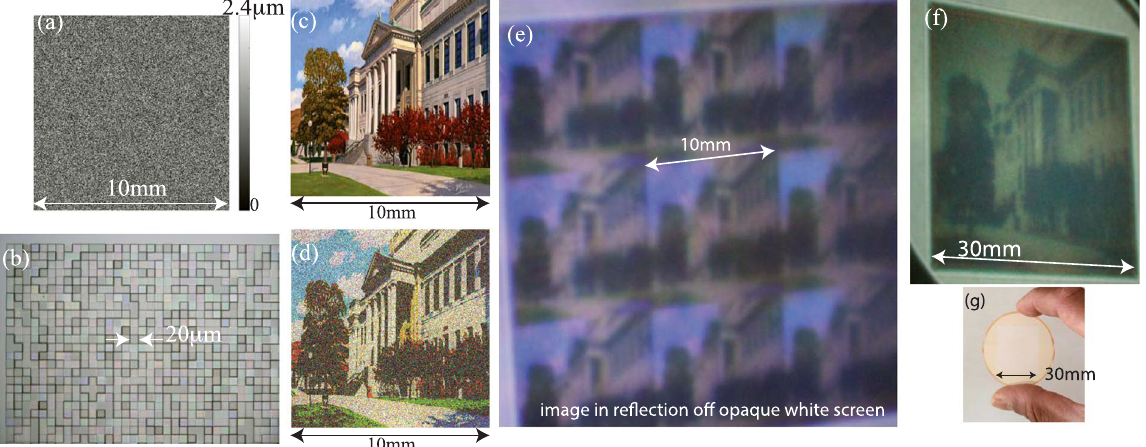
Figure 3. Hologram encoding a color photograph. ( a ) Design height map of the hologram. ( b ) Optical micrograph of a portion of the fabricated device. ( c ) Target image corresponding to the color photograph. Image courtesy of the University of Utah. ( d ) Simulated image created by the hologram, when it is illuminated by the design wavelengths. ( e ) Photograph of the image reflected of a white opaque screen taken at a small oblique viewing angle. ( f ) Photograph of image reflected of a white opaque screen for a single-period hologram containing 1500 X 1500 pixels in a single period. In both ( e ) and ( f ), the hologram is illuminated by the full visible band. ( g ) Photograph of single-period hologram. Its size is 30 mm X 30 mm.